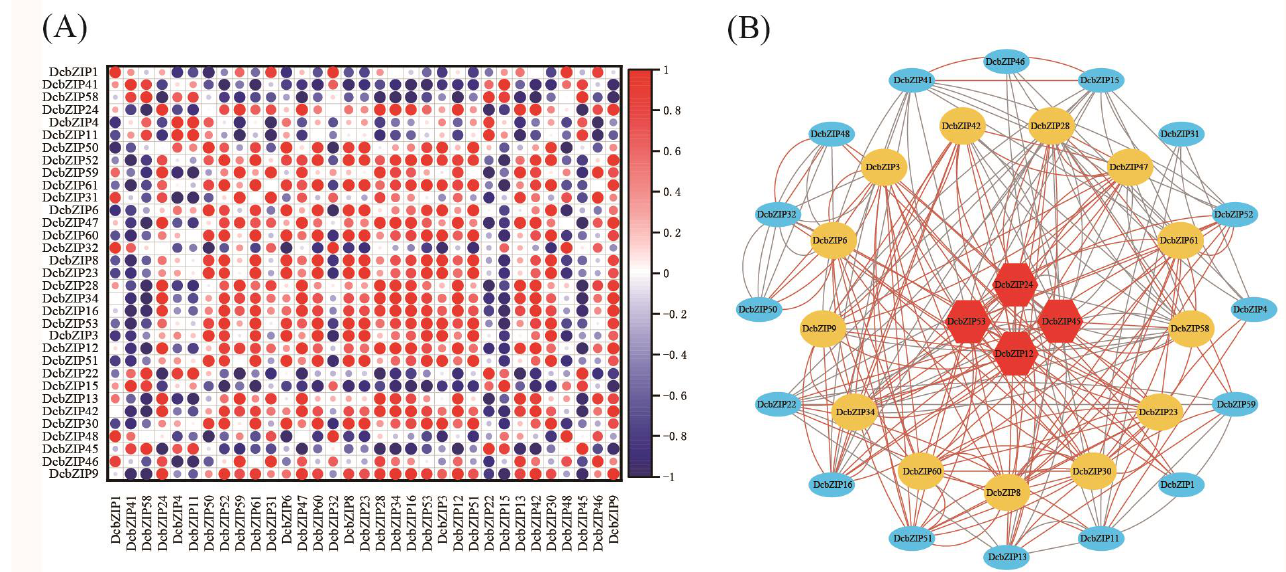
Figure 6. Comprehensive analysis of drought-related DcbZIP genes. ( A ) Correlation analysis of 33 upregulated DcbZIP genes. Red indicates a positive correlation and blue indicates a negative correlation. The circle size indicates the absolute value of the correlation coefficient. ( B ) Co-expression network analysis. The red lines represent a positive correlation. The size represents the degree calculated by the Cytoscape. The four polygons situated in the center represent core genes with high connectivity.